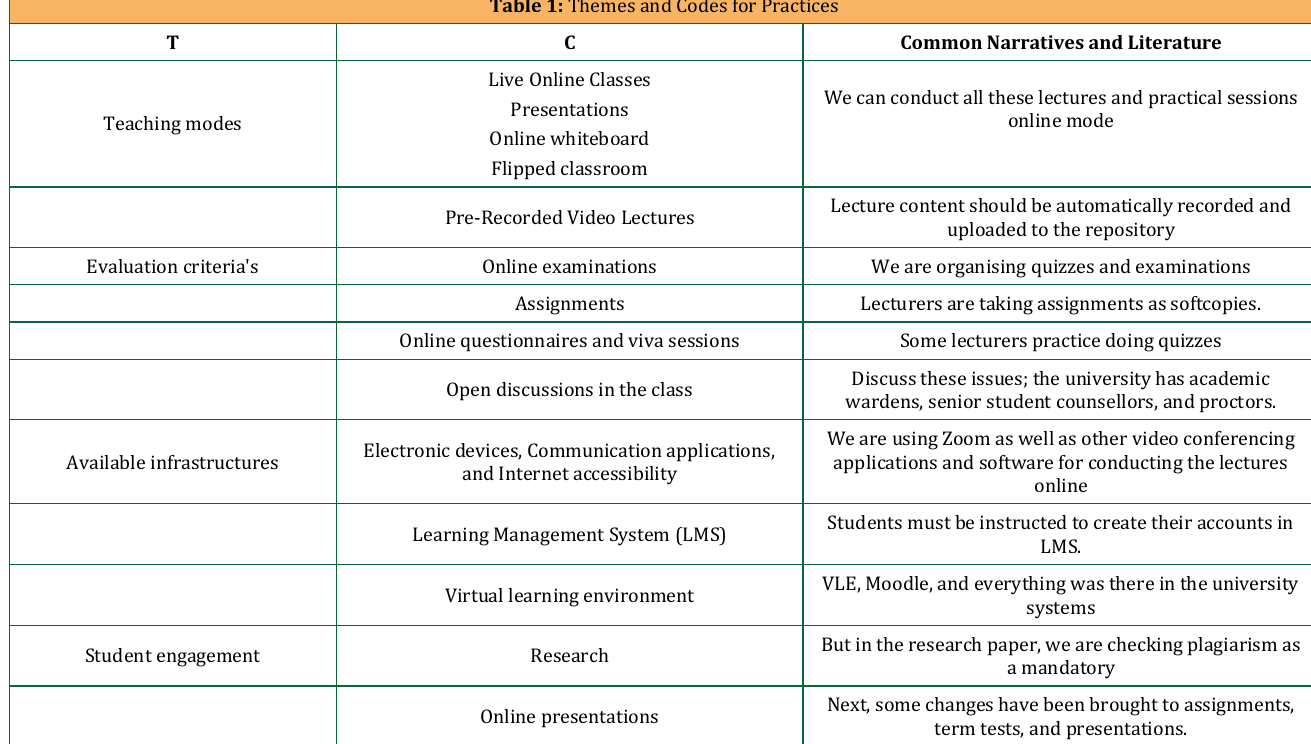
Table 1: Themes and Codes for